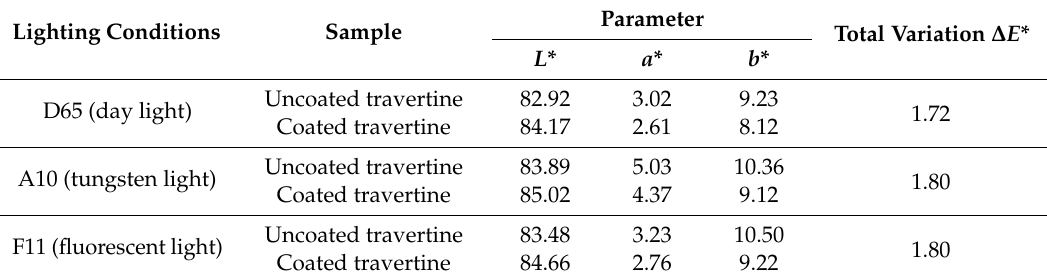
Table 7. Colour and gloss variations of the coated travertine measured according to the CIELAB colour